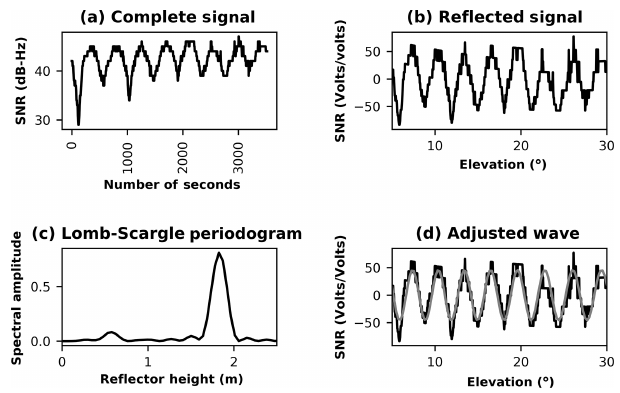
Figure 6. GPS satellite no. 23 observed with the mass-market an- tenna. SNR data in volts (a) , SNR data with the direct signal re- moved (b) , Lomb–Scargle periodogram for the SNR reflected sig- nal (c) , and SNR reflected signal with the adjusted wave (d)